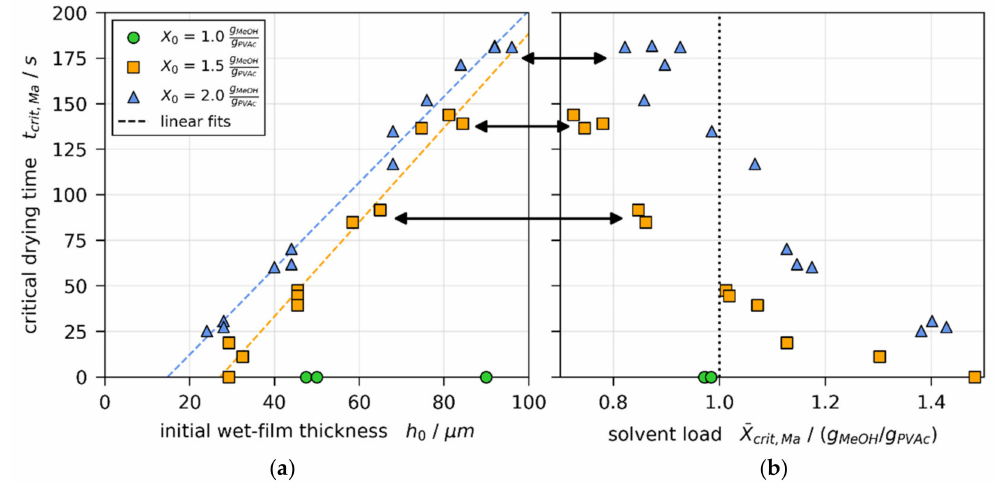
Figure 9. Critical drying time t crit , Ma , denoting the transition from convectively unstable to stable during 3D- µ PTV drying experiments [1]. ( a ) Plotted over initial wet film thickness h 0 from matched simulations. Modified from [1], License: CC-BY 4.0. ( b ) Plotted over height-averaged solvent load X crit , Ma experiment groups where X crit , Ma < 1 g were convectively stable from the start of drying